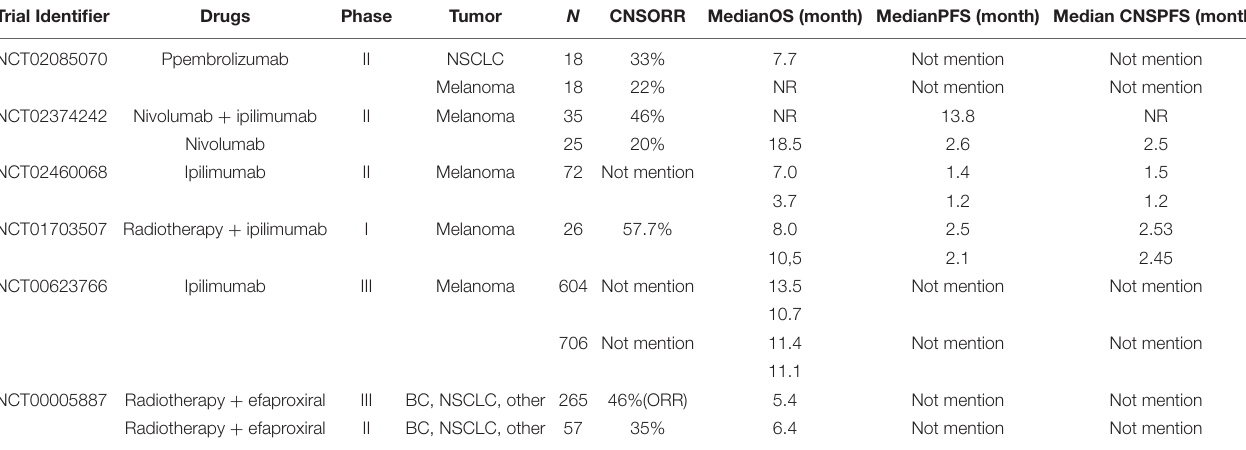
TABLE 1 | A short summary of relevant clinical trials: clinical trials regarding ICP treatments and the allosteric modifier of hemoglobin that have been fully published since 2001–2021. Trial